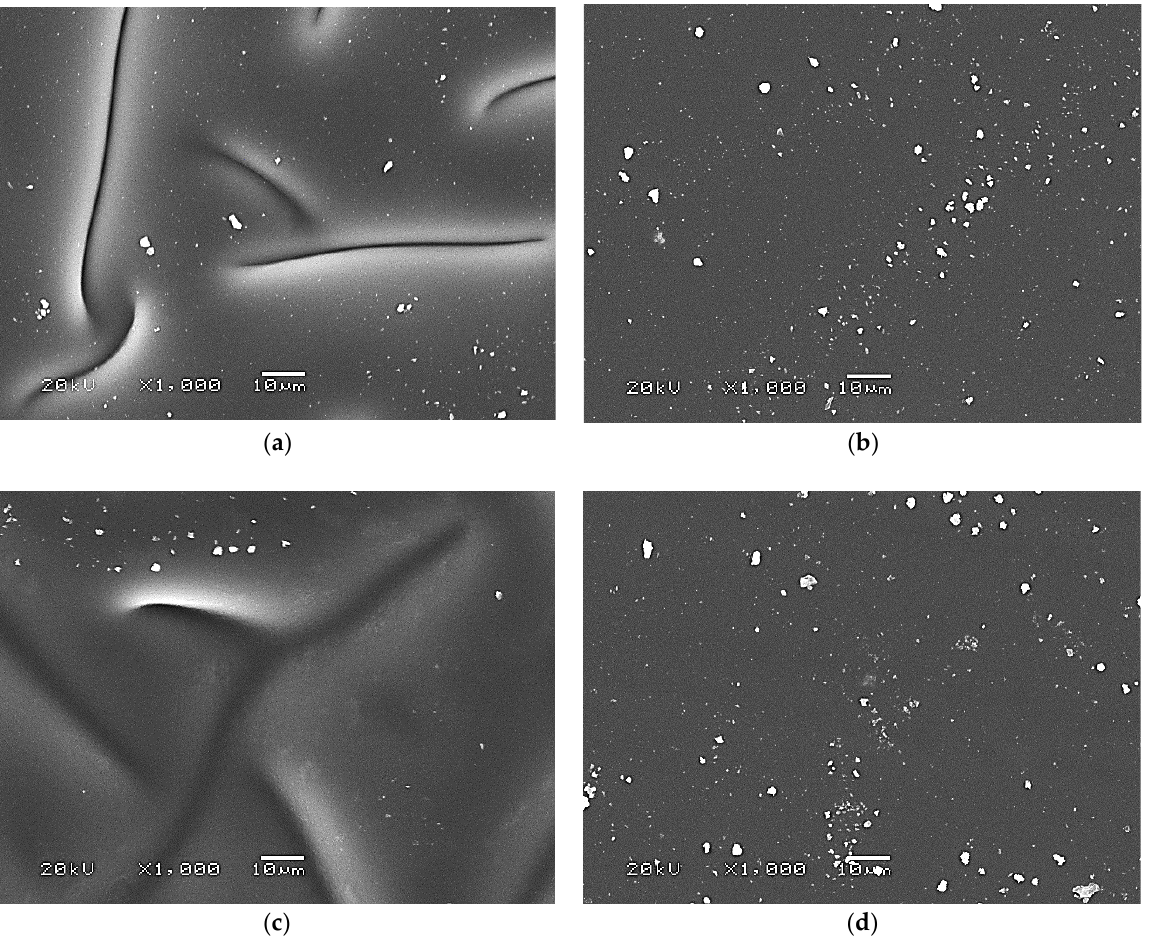
Figure 9. SEM images of hydrogel materials: sample: 0/0 nanoAg ( a ); 5/0 nanoAg ( b ); 0/1 nanoAg ( c ); 5/1 nanoAg ( d ).